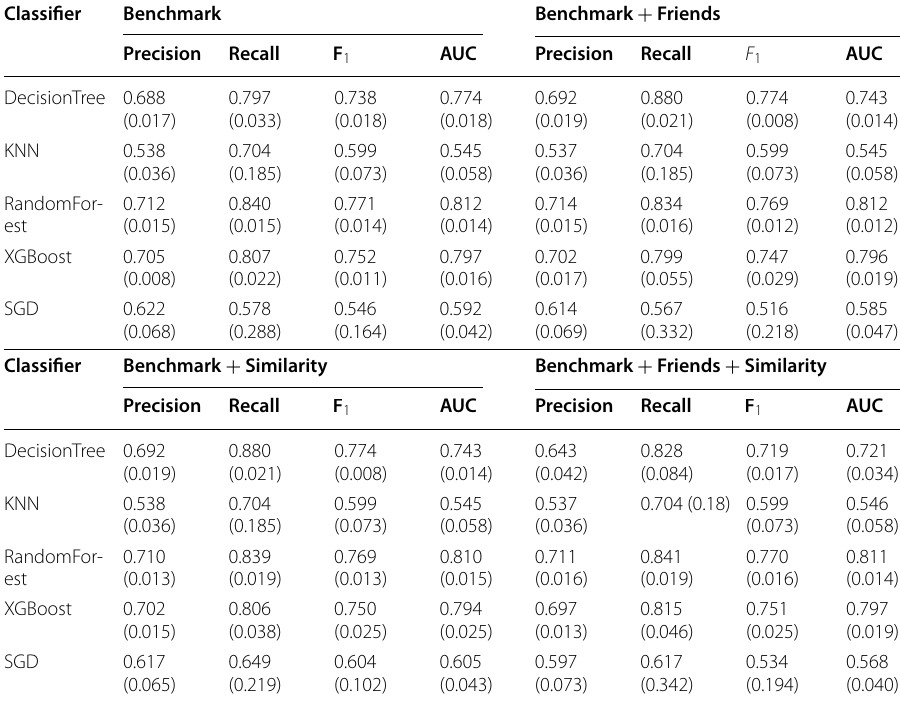
Table 3 Performance, mean and (standard deviation), of churn prediction models for the four feature groups using the 3-day dataset